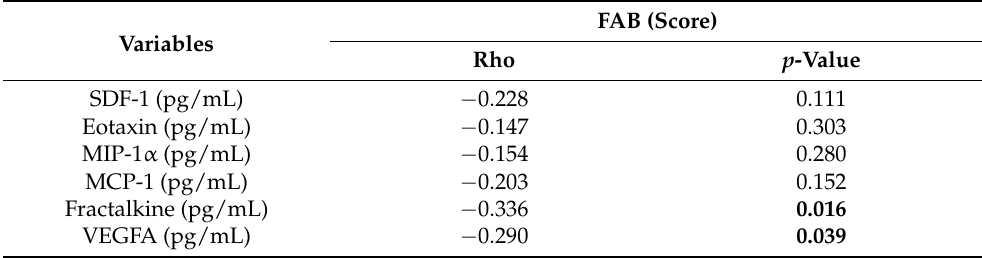
Figure 3. Plasma concentrations of VEGFA and chemokines in AUD patients with frontal cognitive impairment ( n = 28). ( A ) MIP-1 α (pg/mL), ( B ) SDF-1 (pg/mL), ( C ) Eo-taxin (pg/mL), ( D ) Fractalkine (pg/mL), ( E ) MCP-1 (pg/mL), and ( F ) VEGFA (pg/mL). Box and whiskers plotted at the 5–95 percentile. Dots are individual values. Data were analyzed by Kruskal Wallis test. (*) p < 0.05 denote a significant difference compared with AUD patients without frontal deficits. Abbreviations: FCI = Frontal Cognitive Impairment. Table 3. Correlation analysis between FAB scores and plasma concentrations of chemokines and VEGFA in AUD patients ( n = 51). (rho) Spearman’s correlation coefficient. Bold values are statistically significant for p <